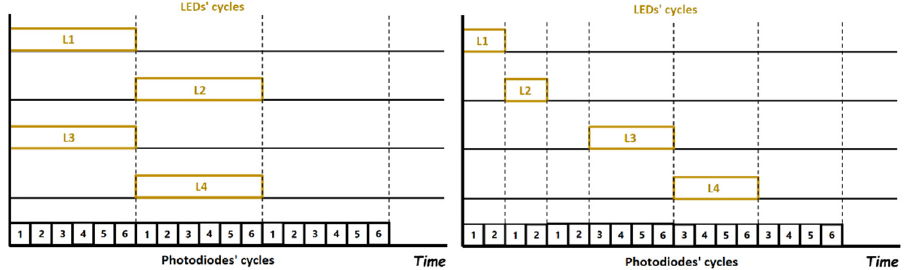
Figure 1. Two possible modes of an LED timing diagram for a device with conventional cerebral optical probes with two photodiodes:L1,L2–peripheral tissue probe LEDs are switched ON; L3,L4—cerebral tissues probe LEDs are switched ON; 1–6—collection of signals from photodiodes: 1,2—peripheral tissue probes, 3–6—cerebral tissue probes.